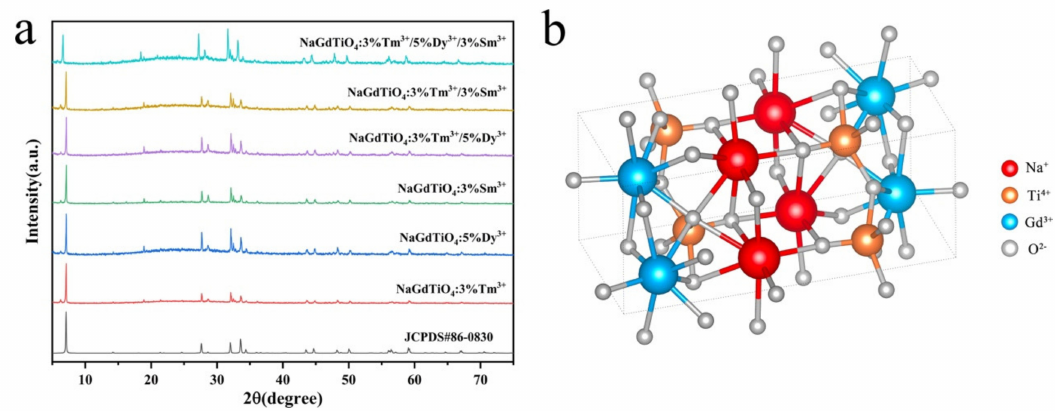
Figure 1. ( a ) XRD patterns of NaGdTiO 4 (NGT): 3%Tm 3 + , NGT: 5%Dy 3 + , NGT: 3%Sm 3 + ,